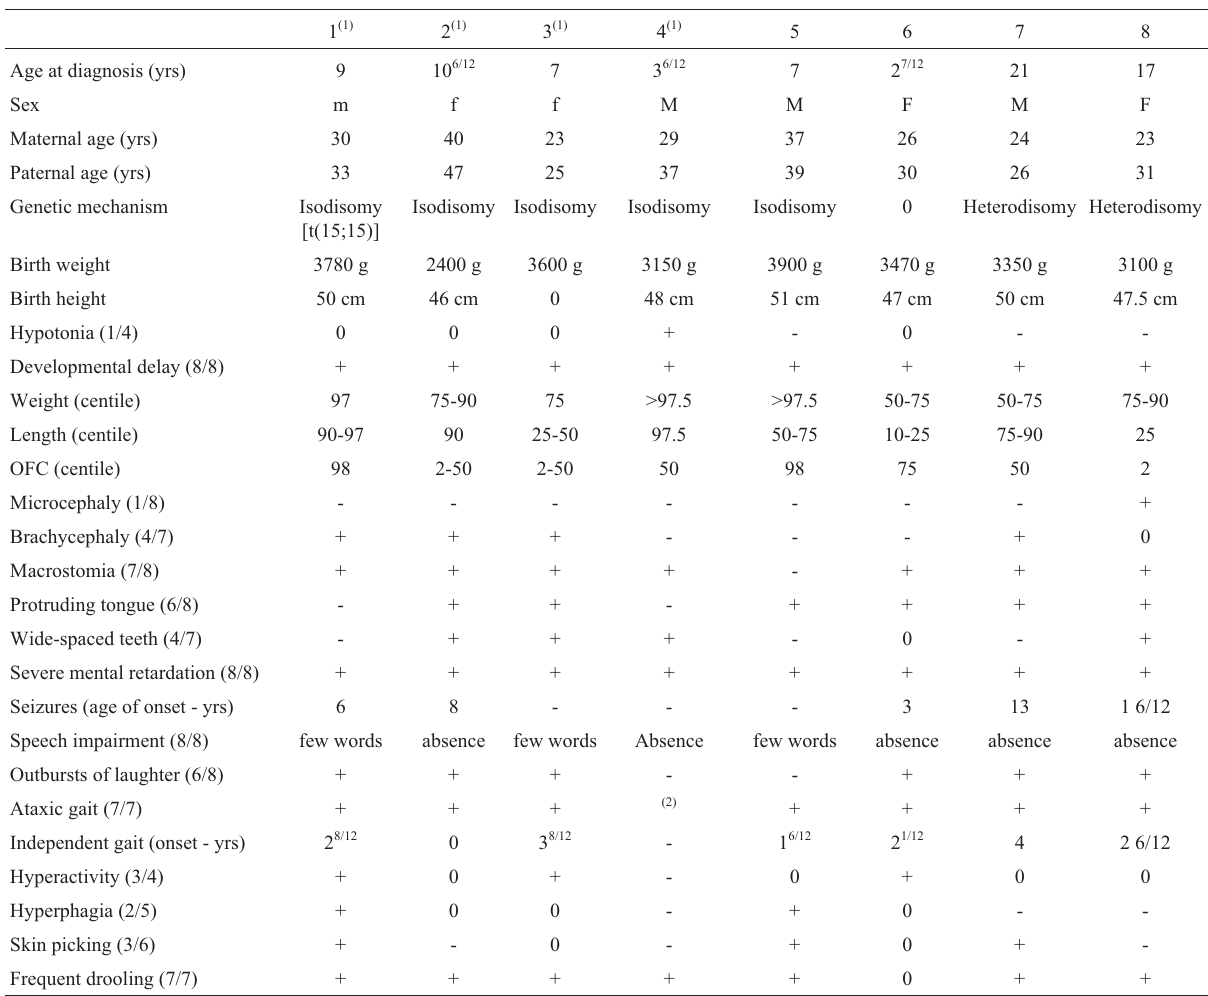
Table I - Clinical features of AS patients with